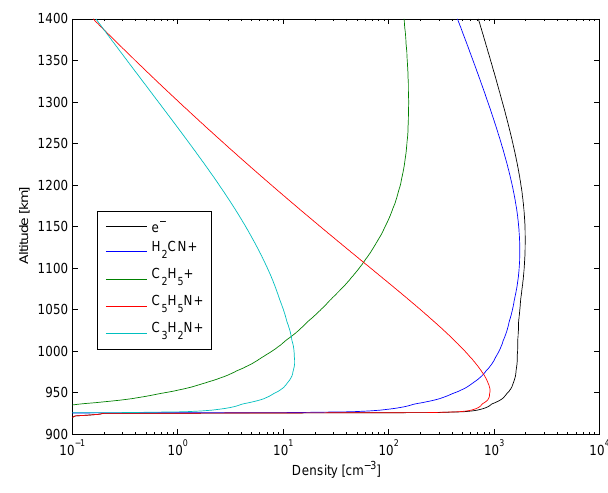
Fig. 11. The total electron density (green), total electron density with a flux reduced by ten (red) and densities for energy values of 30 eV (green dashed), 150 eV (blue dashed) and 500 eV (red dashed) superposed on the measured electron density derived from the fuh-line (blue) and LP (black). The fluxes for the single energies are, respectively, 7 . 9 × 10 5 , 1 . 7 × 10 5 and 4 . 6 × 10 4 cm − 2 s − 1 .